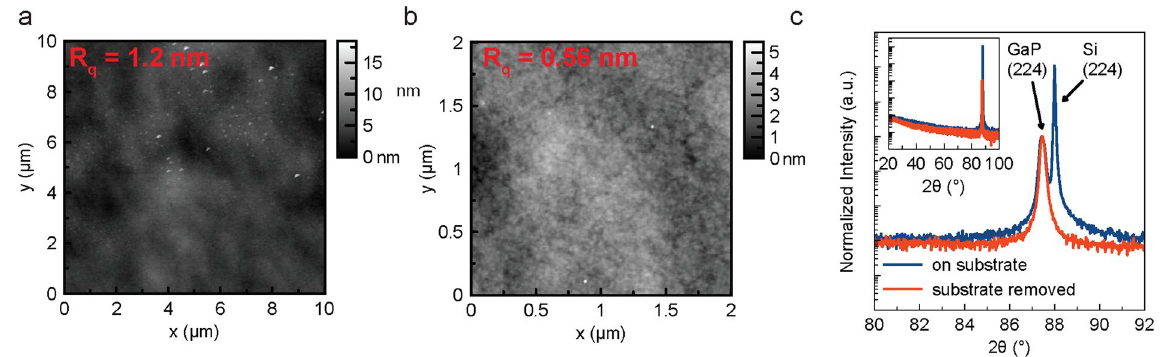
Figure 4. Atomic force micrographs and x-ray diffraction spectra of GaP films. Atomic force microscopy images of the GaP film top surface following growth on silicon ( a ), and following substrate removal ( b ). Note that the top surface following substrate removal is the surface which had previously been in contact with silicon in the as-grown film on substrate. ( c ) x-ray diffraction spectra of the films following substrate removal show that excellent crystallinity is